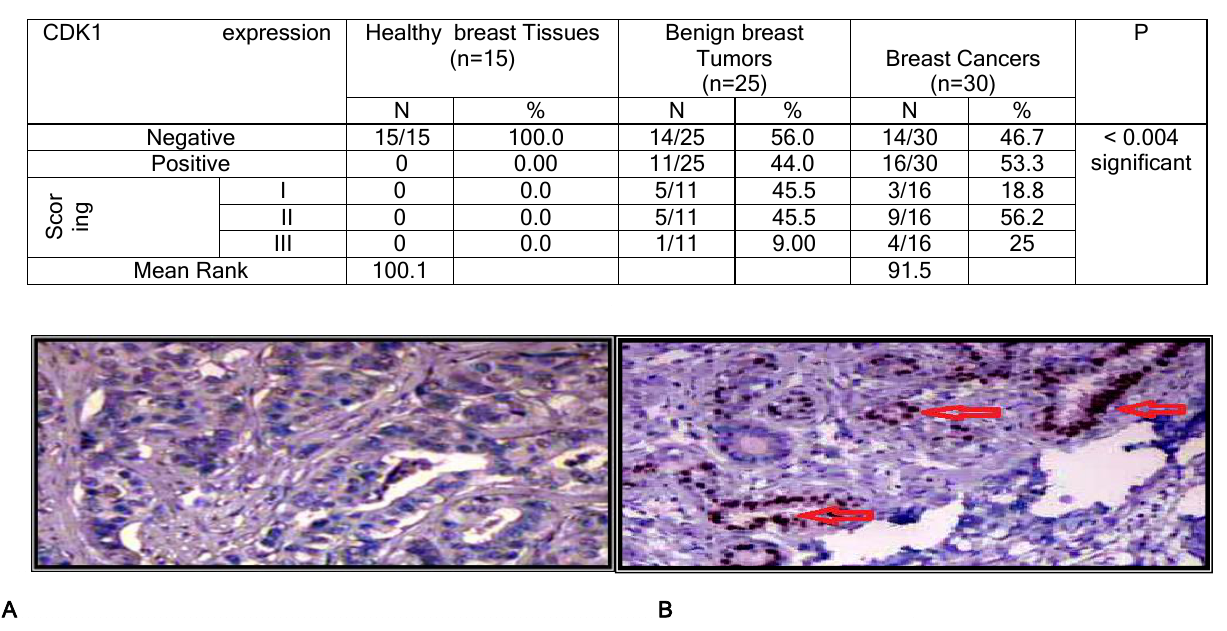
Table (5): Frequency distribution of immunohistochemistry results of CDK1 protein according to the signal scoring.